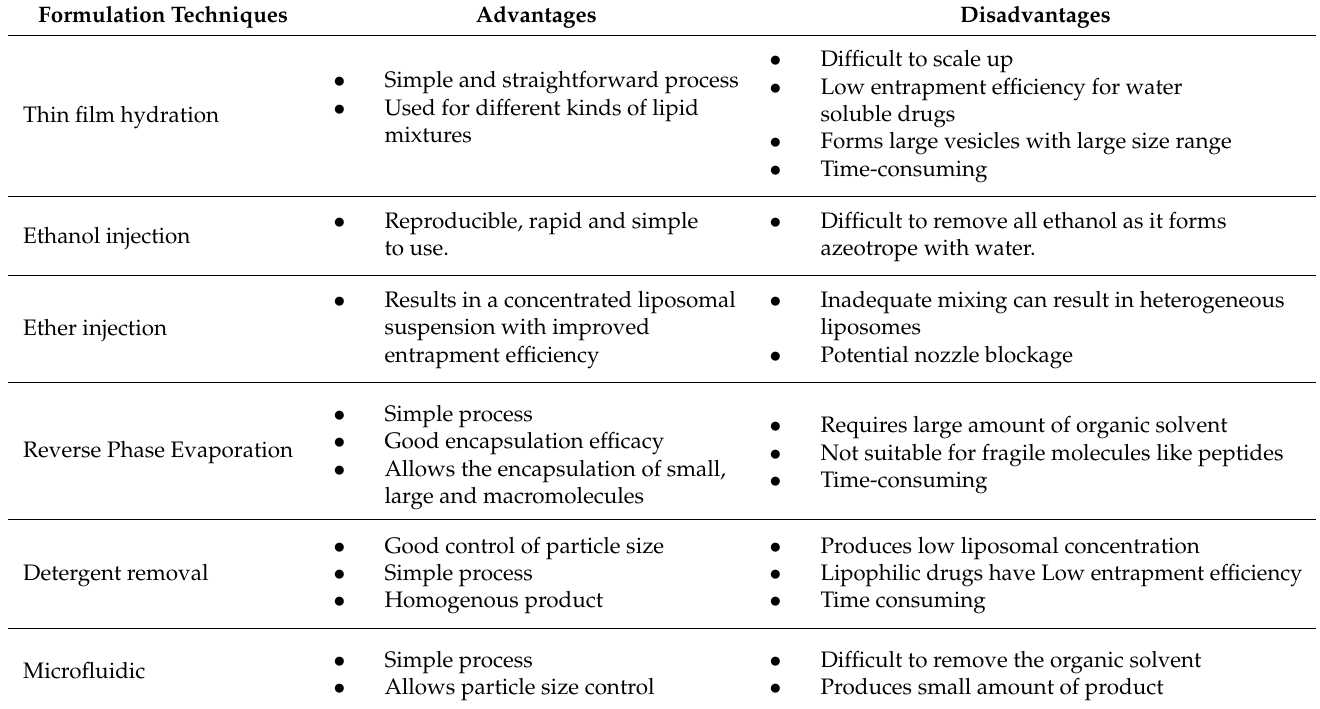
Table 1. Advantages and disadvantages of symmetric liposomes formulation techniques.